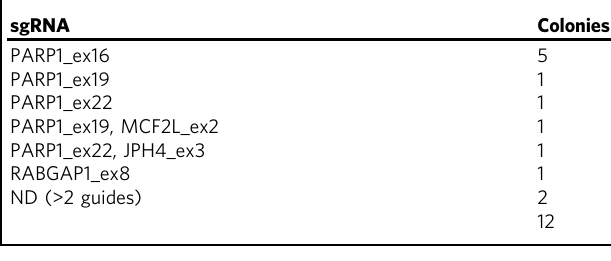
Fig. 2 A focused CRISPR-Cas9 mutagenesis “ tag, mutate and enrich ” screen identi fi es PARP1 mutations outside the DNA-binding domain that cause PARP inhibitor resistance. a Experimental “ tag, mutate and enrich ” scheme to isolate missense and in-frame PARP1 mutants associated with PARP inhibitor resistance. b Translated alignment of PARP1 amino-acid mutations identi fi ed in talazoparib-resistant cells isolated from lentiviral sgRNA pool 1 (designed to target ZnF1 and ZnF2 domains) from the screen shown in a . By comparing the multiple different mutations isolated from pool 1, a PARP1 p.119_120delKS minimal mutation associated with resistance was identi fi ed. Some insertions and larger deletions are omitted for clarity (see Supplementary Data 2). c PARP1 p.119_120delKS mutation abolishes recruitment of a PARP1-GFP fusion to sites of microirradiated DNA damage. CAL51 PARP1 – / – cells were transfected with a wild-type PARP1-GFP cDNA construct or a PARP1 p.119_120delKS-GFP fusion cDNA expression construct and then exposed to localised ionising radiation (a microirradiated spot) as in f . Time course of PARP1-GFP signal at microirradiated site is shown. d Location of three mutations associated with PARPi resistance on a model of the PARP1 DNA structure 12 . e PARP1-N329Q and HD742F mutations ablate PARP1 trapping, while 848delY partially reduces trapping. Western blot from PARP1 trapping assay for three PARP1-GFP mutants and wild-type PARP1-GFP is shown. MMS-treated cells were lysed and fractionated into nuclear soluble (NS) and chromatin (C) fractions as described in Methods. Blot was probed with an anti-GFP antibody. f PARP1-848delY mutation alters PARP1 localisation kinetics at sites of DNA damage. Microirradiation and PAR synthesis phenotypes of N329Q and 848delY PARP1 mutants. Green — PARP1-GFP signal, red — PAR sensor (PBZ-mRuby2). Note lower recruitment relative to wild type of both mutants, but retention of PAR synthesis in 848delY. g Model of intramolecular communication between the DNA-binding ZnF1 domain and the catalytic (CAT) domain based on mutants identi fi ed from screens. (1) 45delD mutation in fi rst zinc fi nger, (2) HD742F mutation shown in d , (3) E688 (Supplementary Data 2)